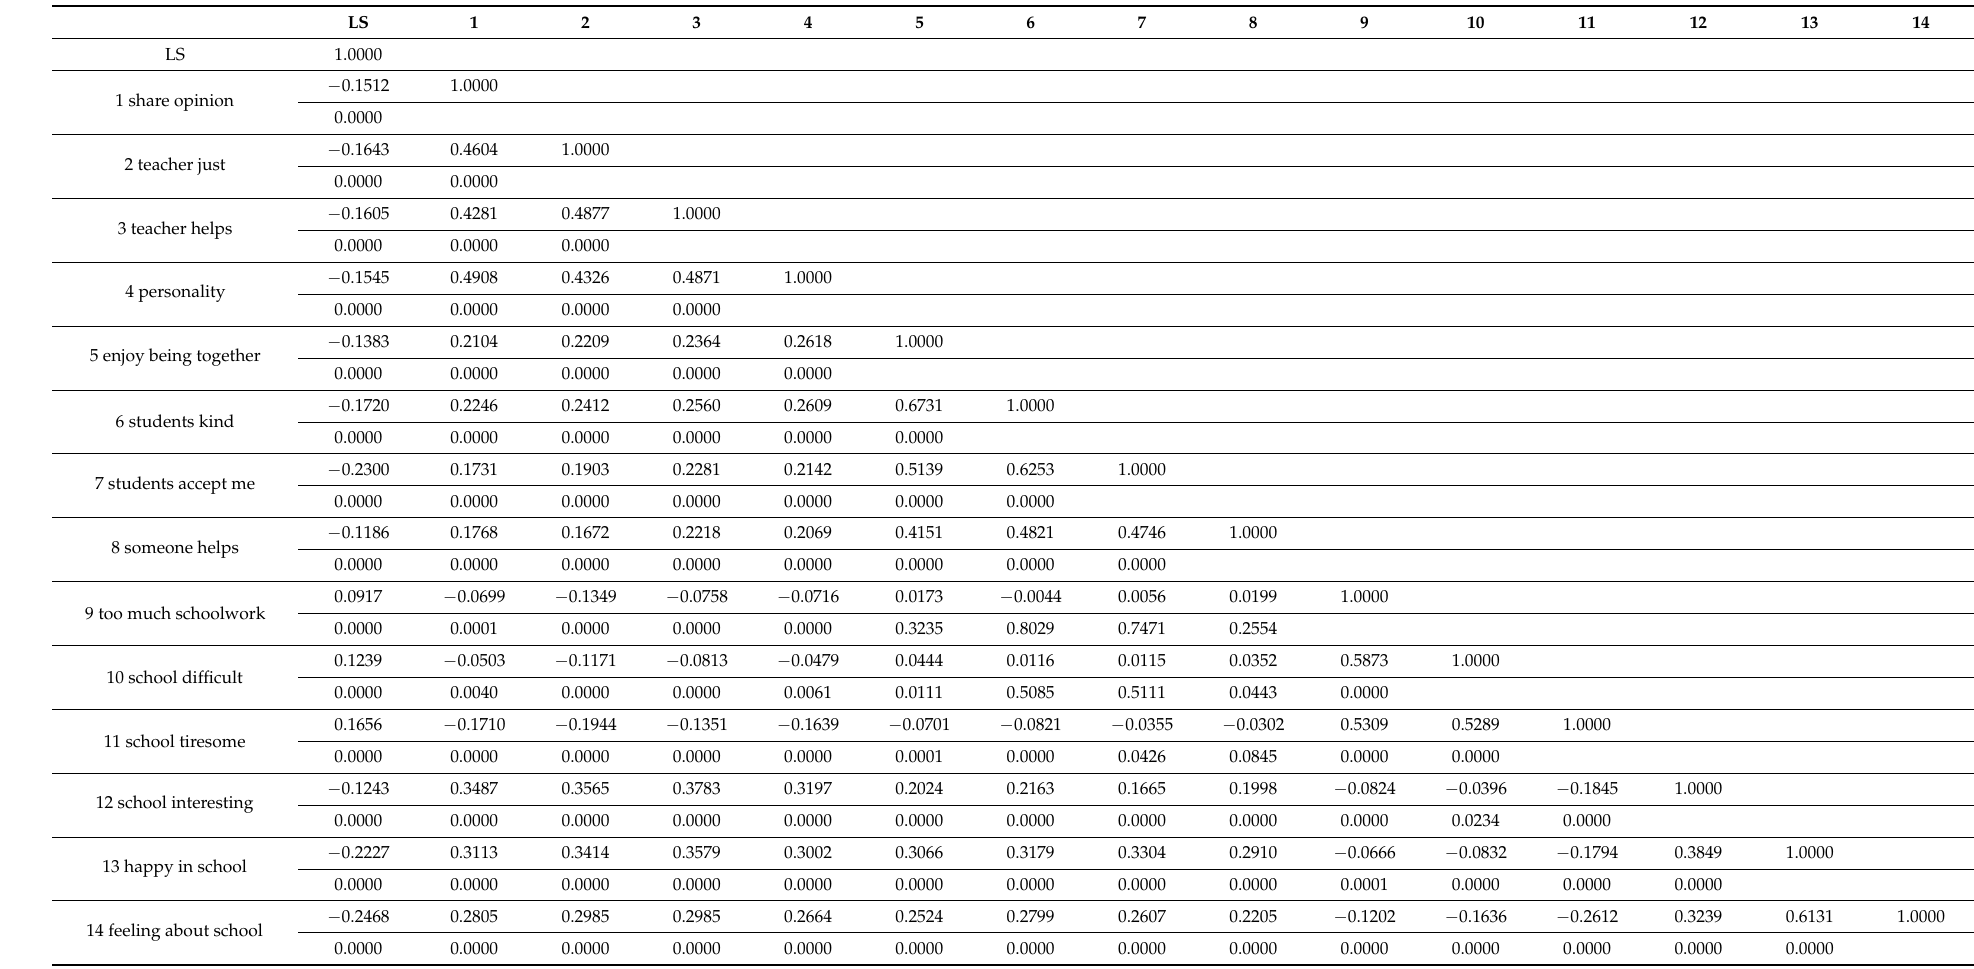
Table 2. Spearman’s rank correlation coefficients with p values for the correlation of school-related items with life satisfaction